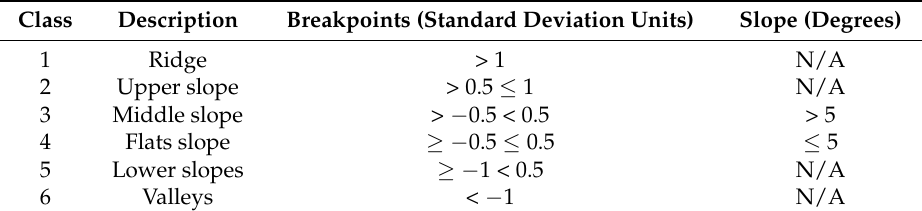
Table 2. Slope position classification thresholds. Reproduced from Weiss [48].